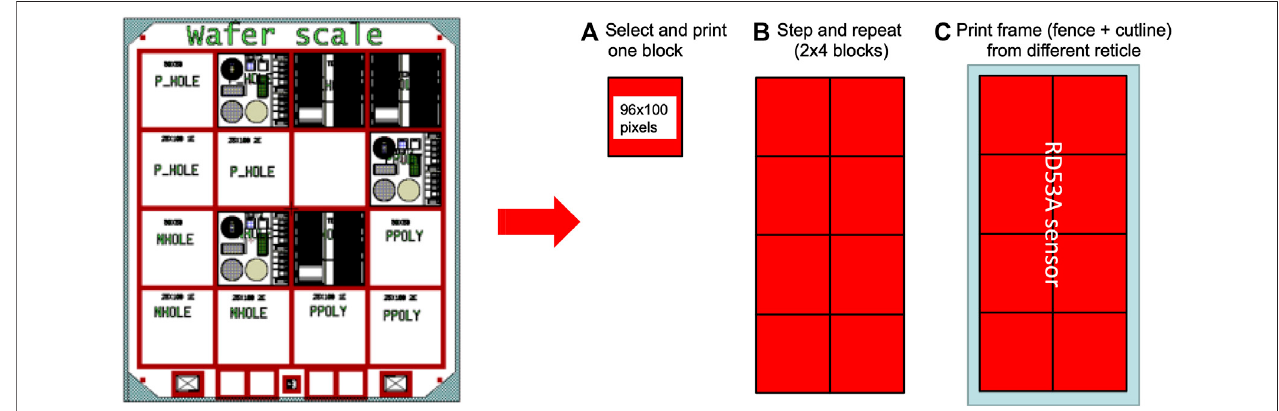
FIGURE 6 | Example of reticle layout and exposure strategy used with stepper in batch